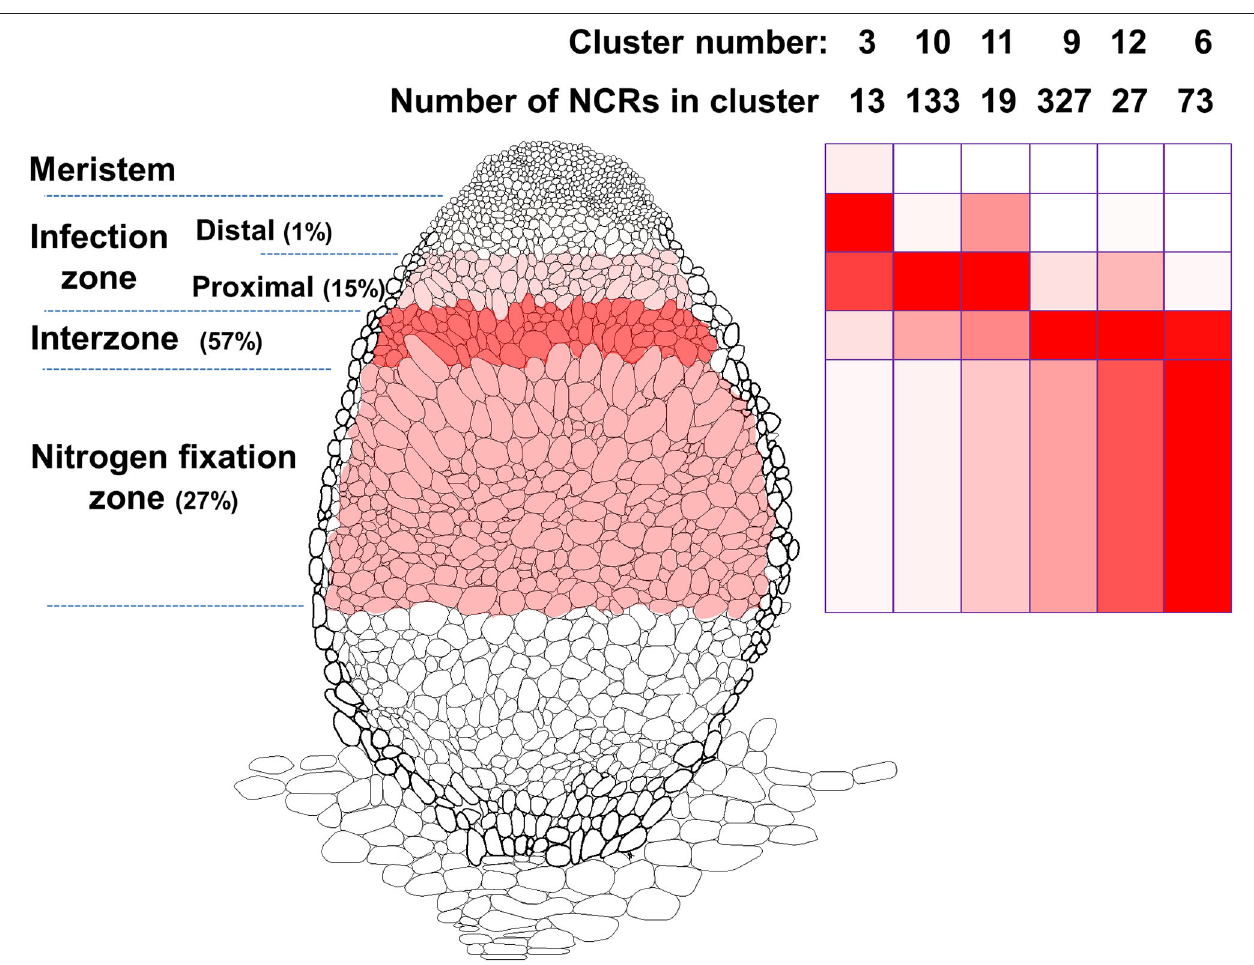
FIGURE 1 | Model of a M. truncatula nodule illustrating the patterns of expression of NCR genes. The different stages of nodule development are named on the left . The intensity of color in the cells of these zones in the nodule reflects the relative expression of all the NCRs based on the data from Roux et al. (2014). NCRs were grouped into clusters by Roux et al. (2014) based on their expression patterns and the relative levels of expression of NCRs in the six clusters representing most of the NCRs are shown on the right panel. The color intensity illustrates their average patterns of expression in the different developmental stages with which they are